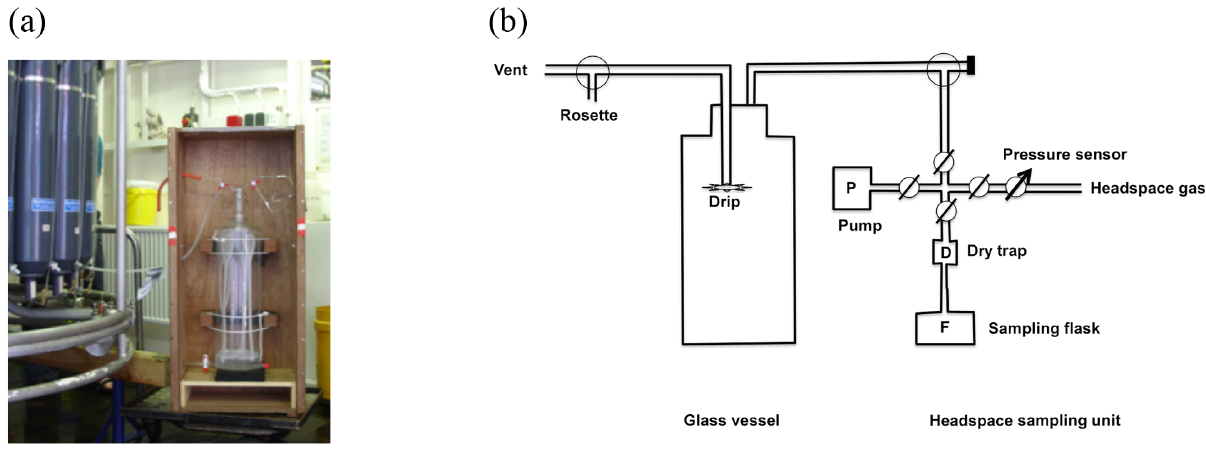
Figure 2. Experimental setup for headspace sampling, (a) sampling of the surface water into the glass vessel, connected to the Niskin bottle rosette, (b) scheme of the experimental